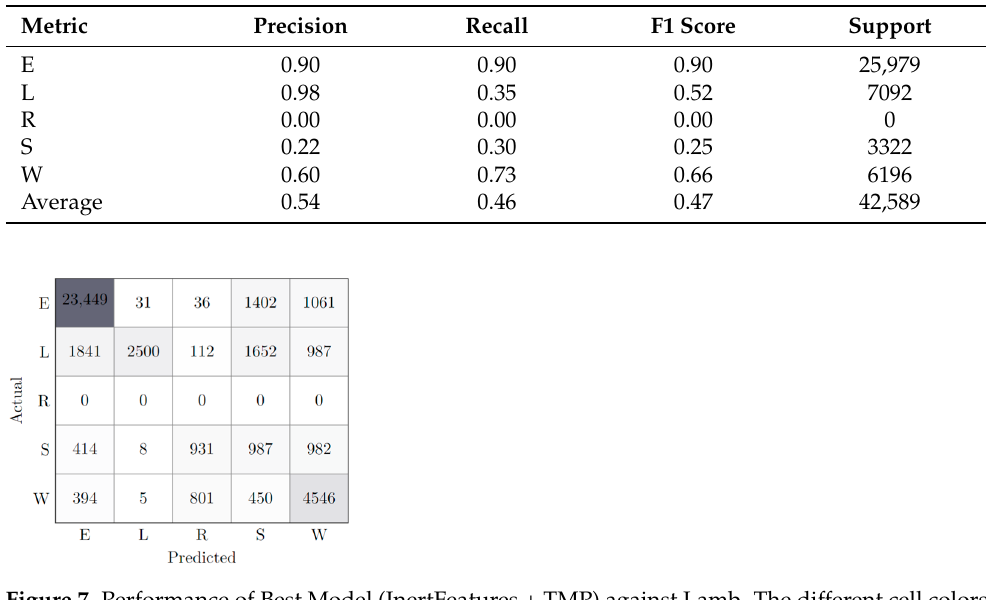
Table 8. Scores of best model (InertFeatures + TMP) against Lamb.